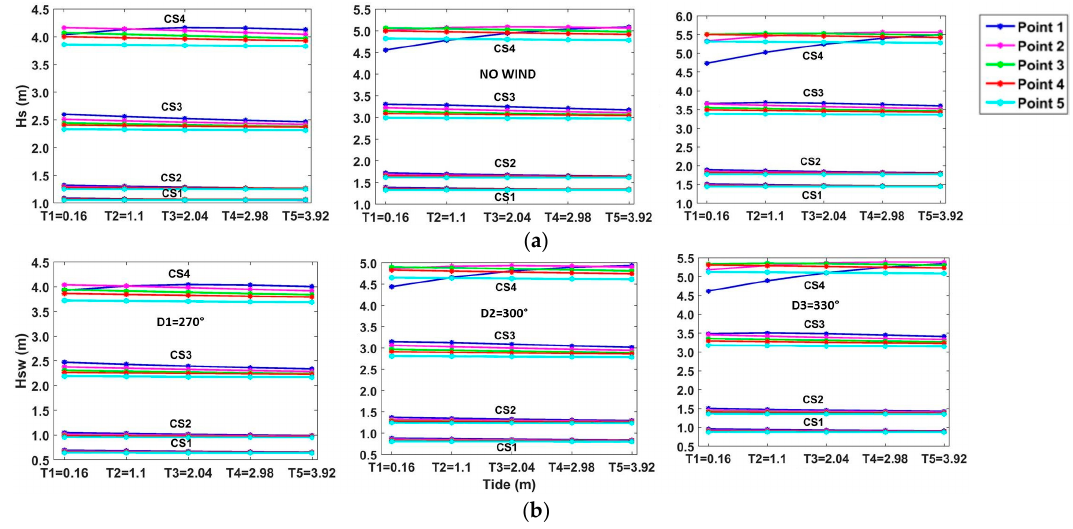
Figure 8. No ‐ wind conditions: variations along the reference points corresponding to the three different directions considered for the incoming waves (D1 = 270°, D2 = 300°, D3 = 330°) and to the five tide conditions (T1, T2, T3, T4, and T5) for all the case studies considered (CS1, CS2, CS3, CS4): ( a ) significant wave height ( H s ); and ( b ) significant wave height of the swell ( H sw ).